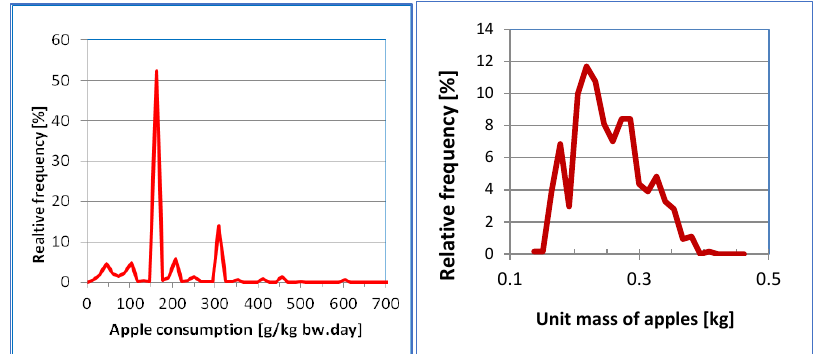
Figure 3. Relative frequency distribution of apple consumption [g/kgbw day] in 4720 days and unit mass (922) of apples [kg].